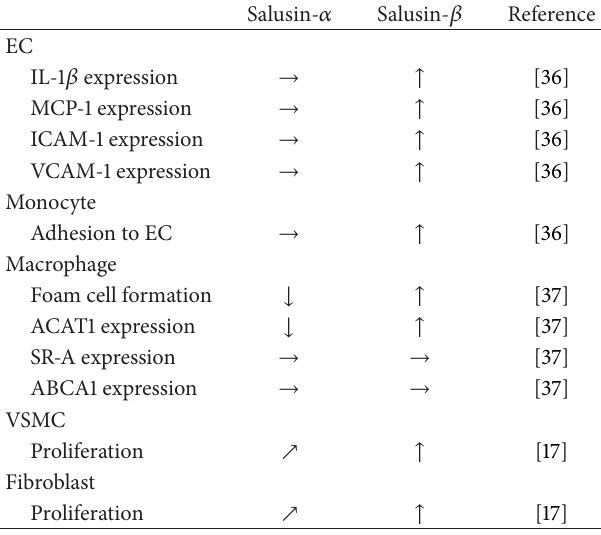
Table 1: Atherogenic effects of salusins on human vascular